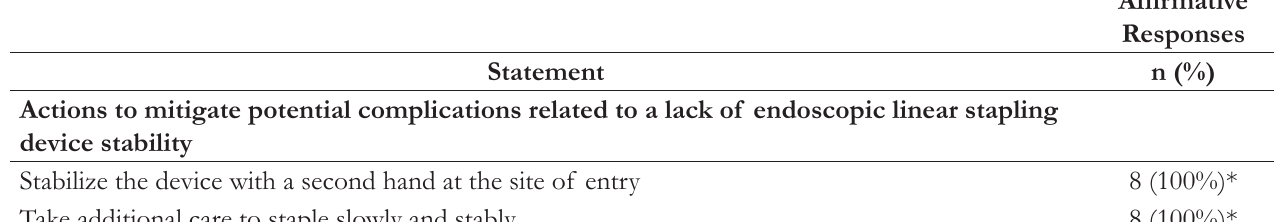
Table 3. Survey 2: Results on theImpact of Device Stability on Surgeon Stress/Concern